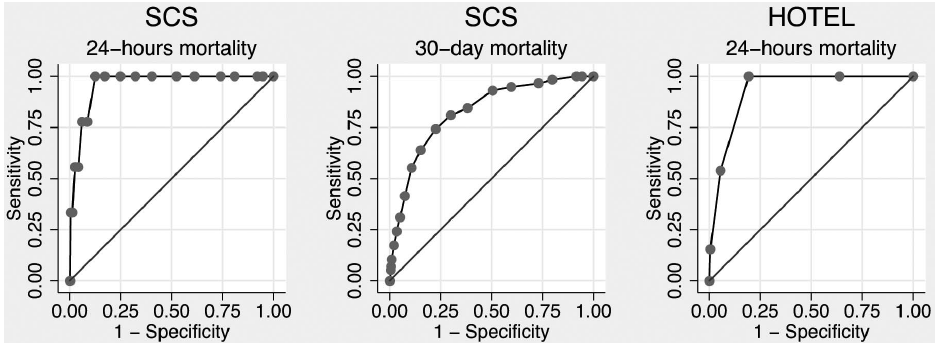
Figure 1. Comparison of area under the receiver operating characteristic curve of each scoring system.